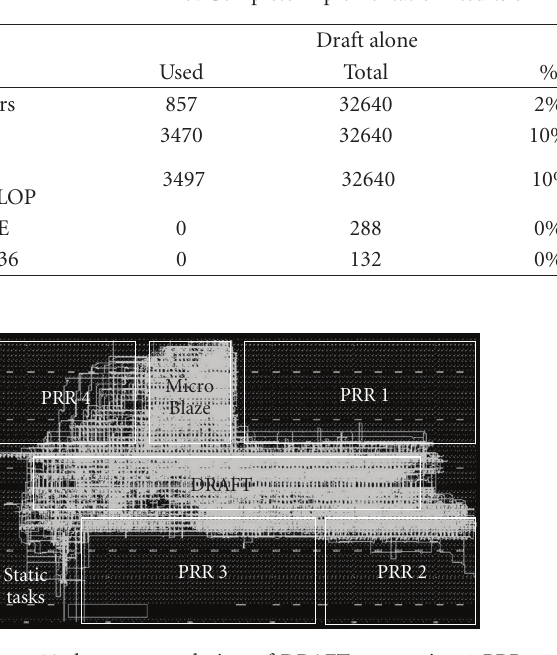
Figure 17: 90-degree rotated view of DRAFT connecting 4 PRRs and 4 shared